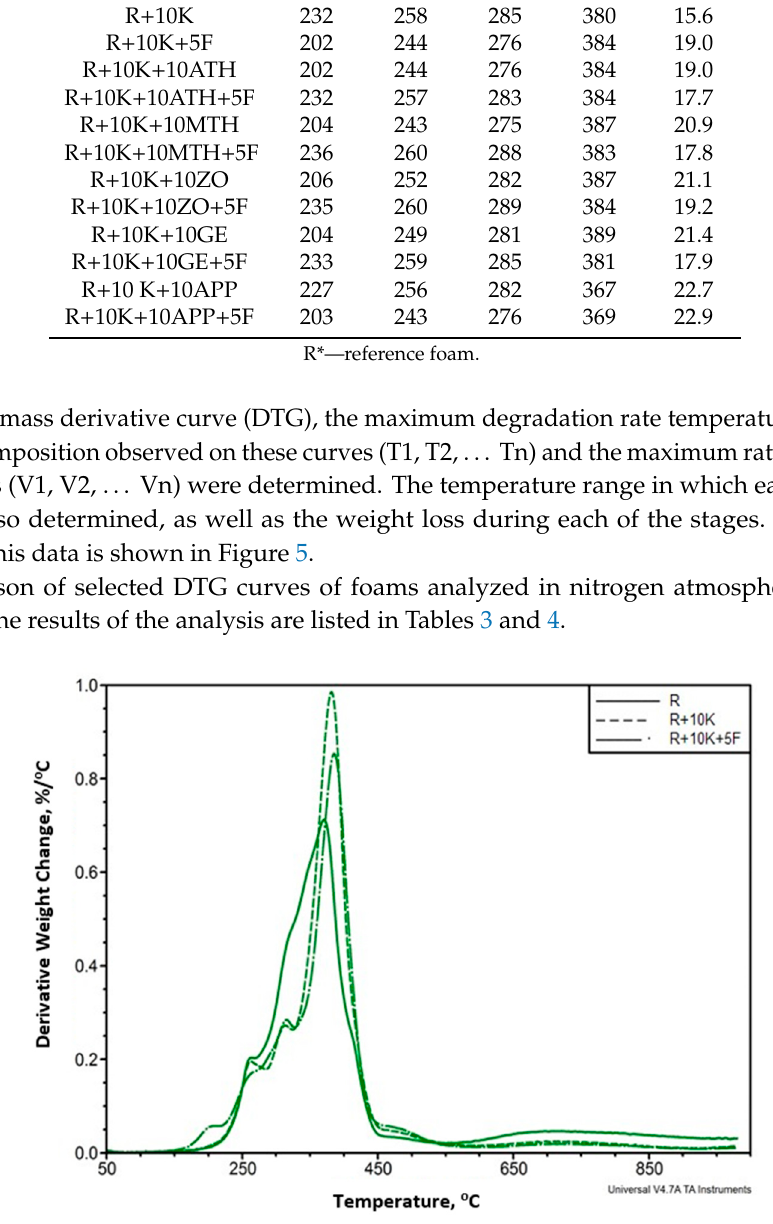
Figure 6. Summary of the results of the Derivative Thermogravimetry DTG analysis of the reference sample (R), foam containing 10% keratin (R + 10K) and foam containing 10% keratin and 5% Fyrol (R + 10K + 5F).